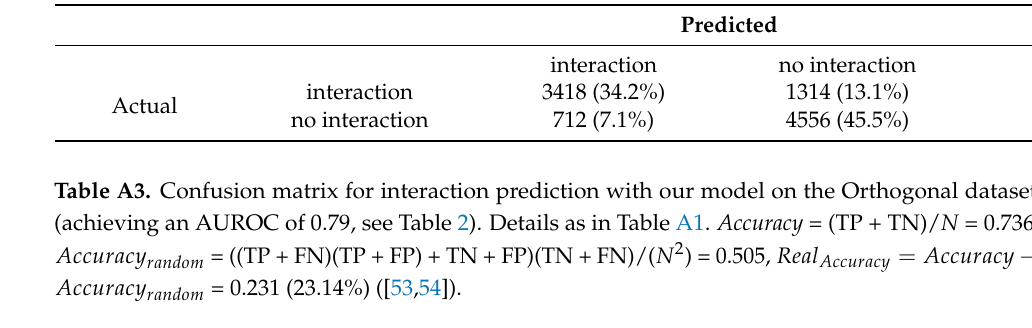
Table A2. Confusion matrix for interaction prediction with our model on the MaSIF dataset (achiev- ing an AUROC of 0.88, see Table 2). Details as in Table A1. Accuracy = (TP + TN)/ N = 0.797,